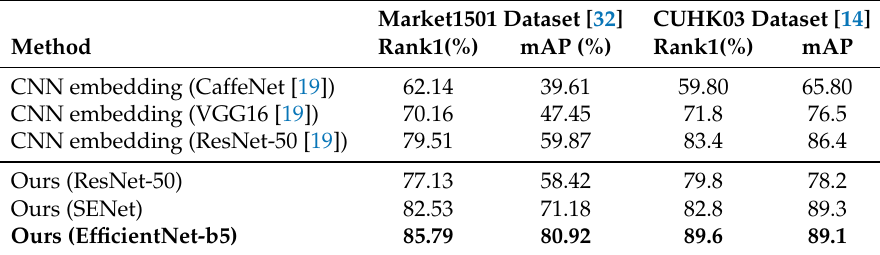
Table 5. Comparison of the results at Rank 1 and mAP on public